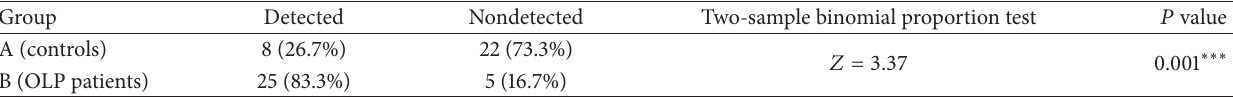
Table 4: Difference in proportion between detected and nondetected TNF- 𝛼 values in serum of Group A and Group B.